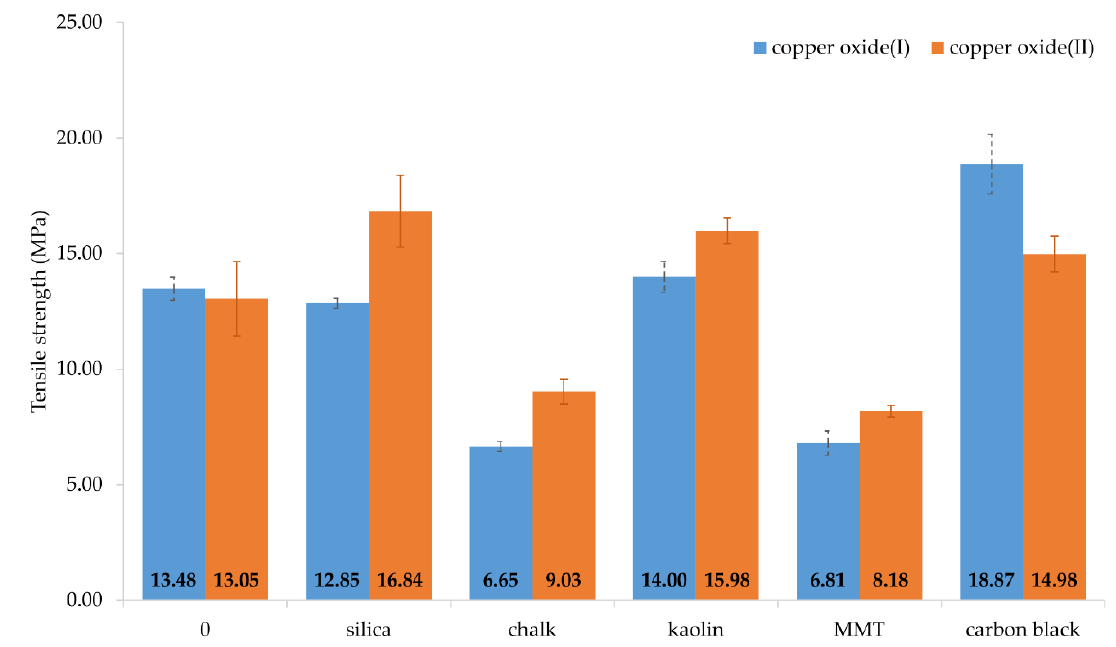
Figure 5. Tensile strength of filled CR vulcanizates; T = 160 °C, t = 45 min; where: Cu 2 O as a cross-linking agent,